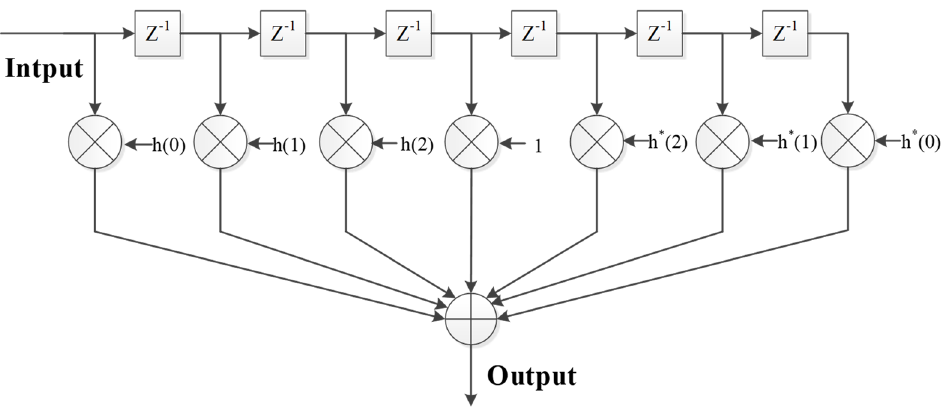
Figure 4. Architecture of the time-domain anti-jamming filter.